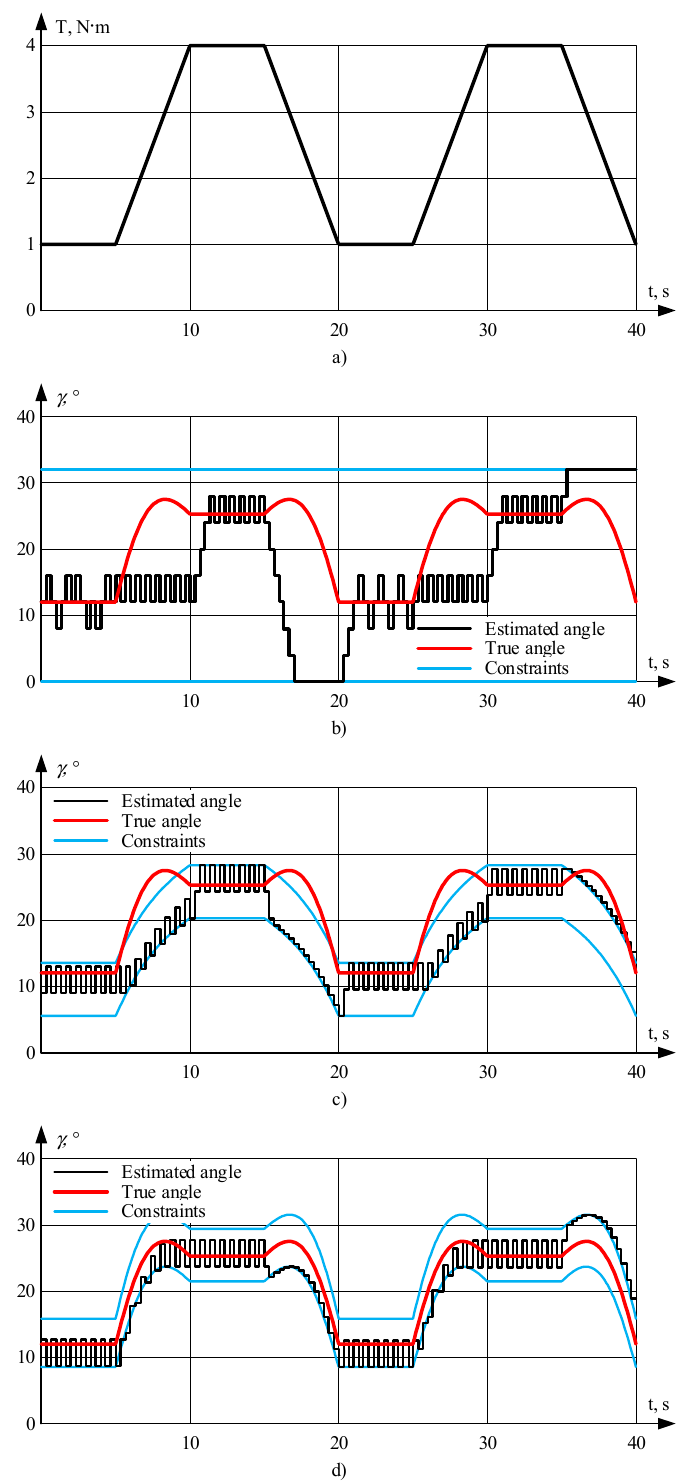
Figure 17. Operation of the seeking algorithm with different constraints at medium load. ( a ) Torque profile; ( b ) Fixed limits; ( c ) Rated MTPA curve with gaps; and ( d ) Proposed technique.